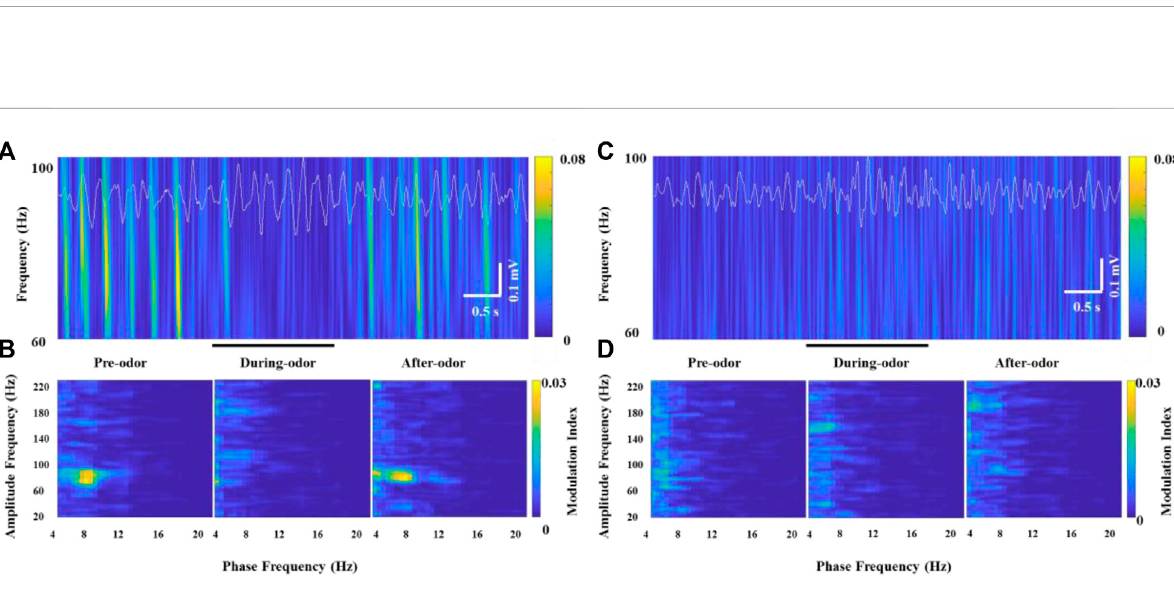
FIGURE 5 Example of speci fi c coupling between θ and high γ oscillations (60 – 100 Hz) in an awake rat (A,B) and an anesthetized rat (C,D) during odor stimulation. (A) Wavelet spectrograms and superimposed θ signals (4 – 12 Hz, white traces) from the recorded OB neurons in an awake rat pre-odor (left),during odor(middle),andafterodor(right). (B) Comodulationmapsobtained fromtheOBneuronsofafreelymovingratpre-odor(left),during odor (middle), and after odor (right). (C) Wavelet spectrograms and superimposed θ signals (4 – 12 Hz, white traces) from the recorded OB neurons in an anesthetized rat pre-odor (left), during odor (middle), and after odor (right). (D) Comodulation maps obtained from the OB neurons of an anesthetized rat pre-odor (left), during odor (middle), and after odor